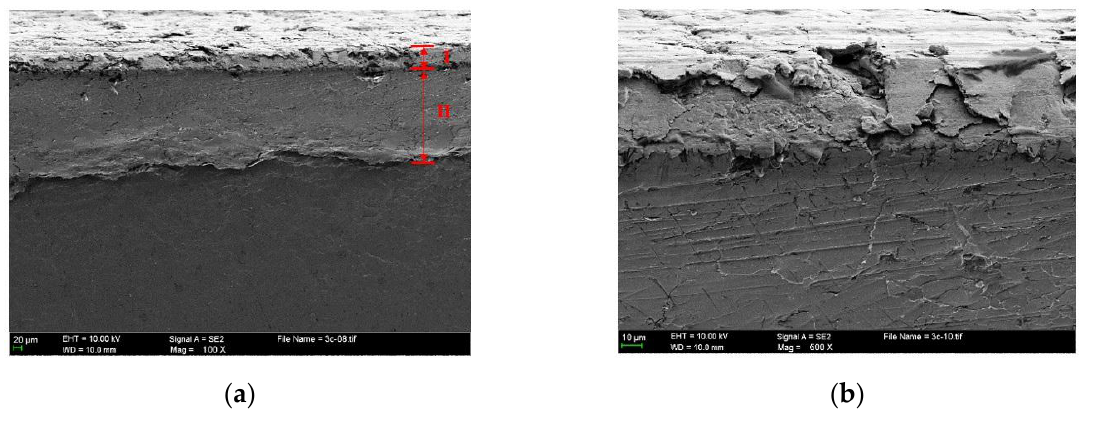
Figure 11. Cross section overview ( a ) and magnified ( b ) morphology of severely damaged region from the scuffed liner of CKS/Fe.